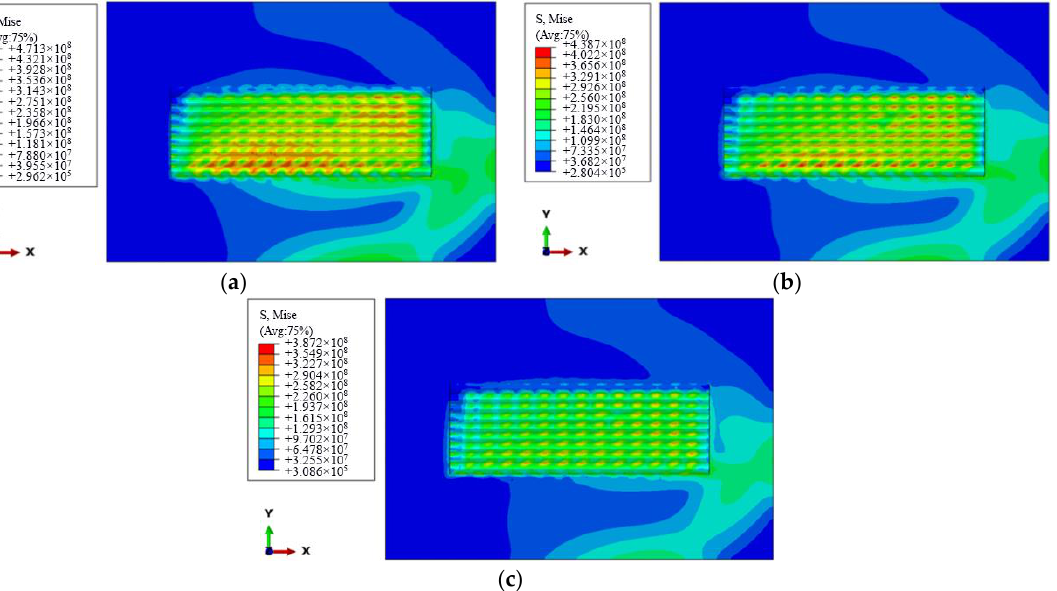
Figure 6. Influence nephogram distribution of scanning speed on stress field: ( a ) scanning speed 80 mm/min; ( b ) scanning speed 90 mm/min; ( c ) scanning speed 100 mm/min.